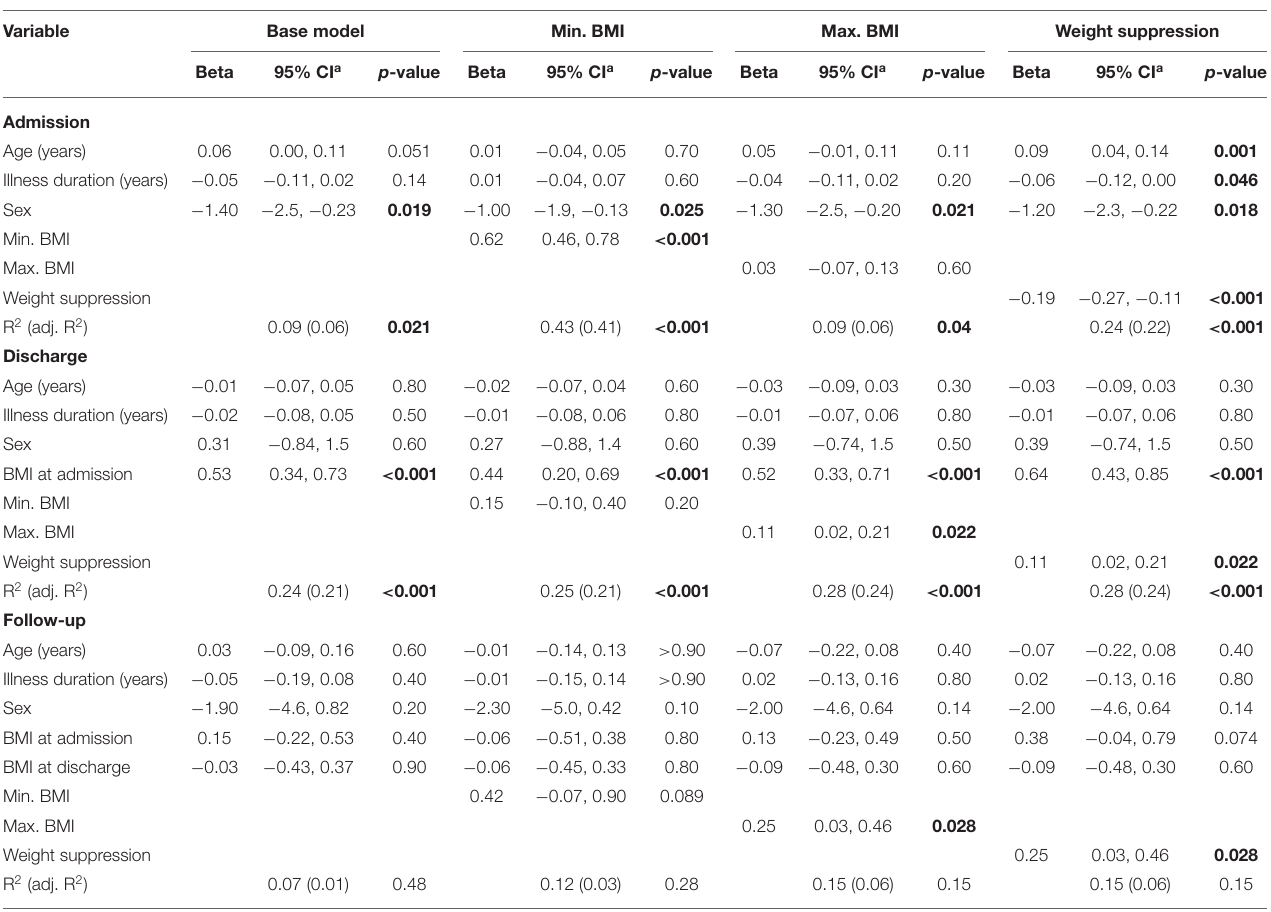
TABLE 2 | Summary of regression models for BMI at admission, discharge and